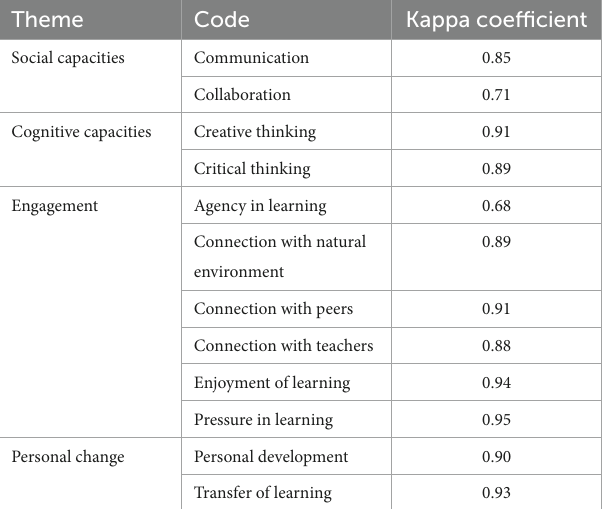
TABLE 6 Qualitative codes and themes, with Kappa coefficient of inter- rater agreement.